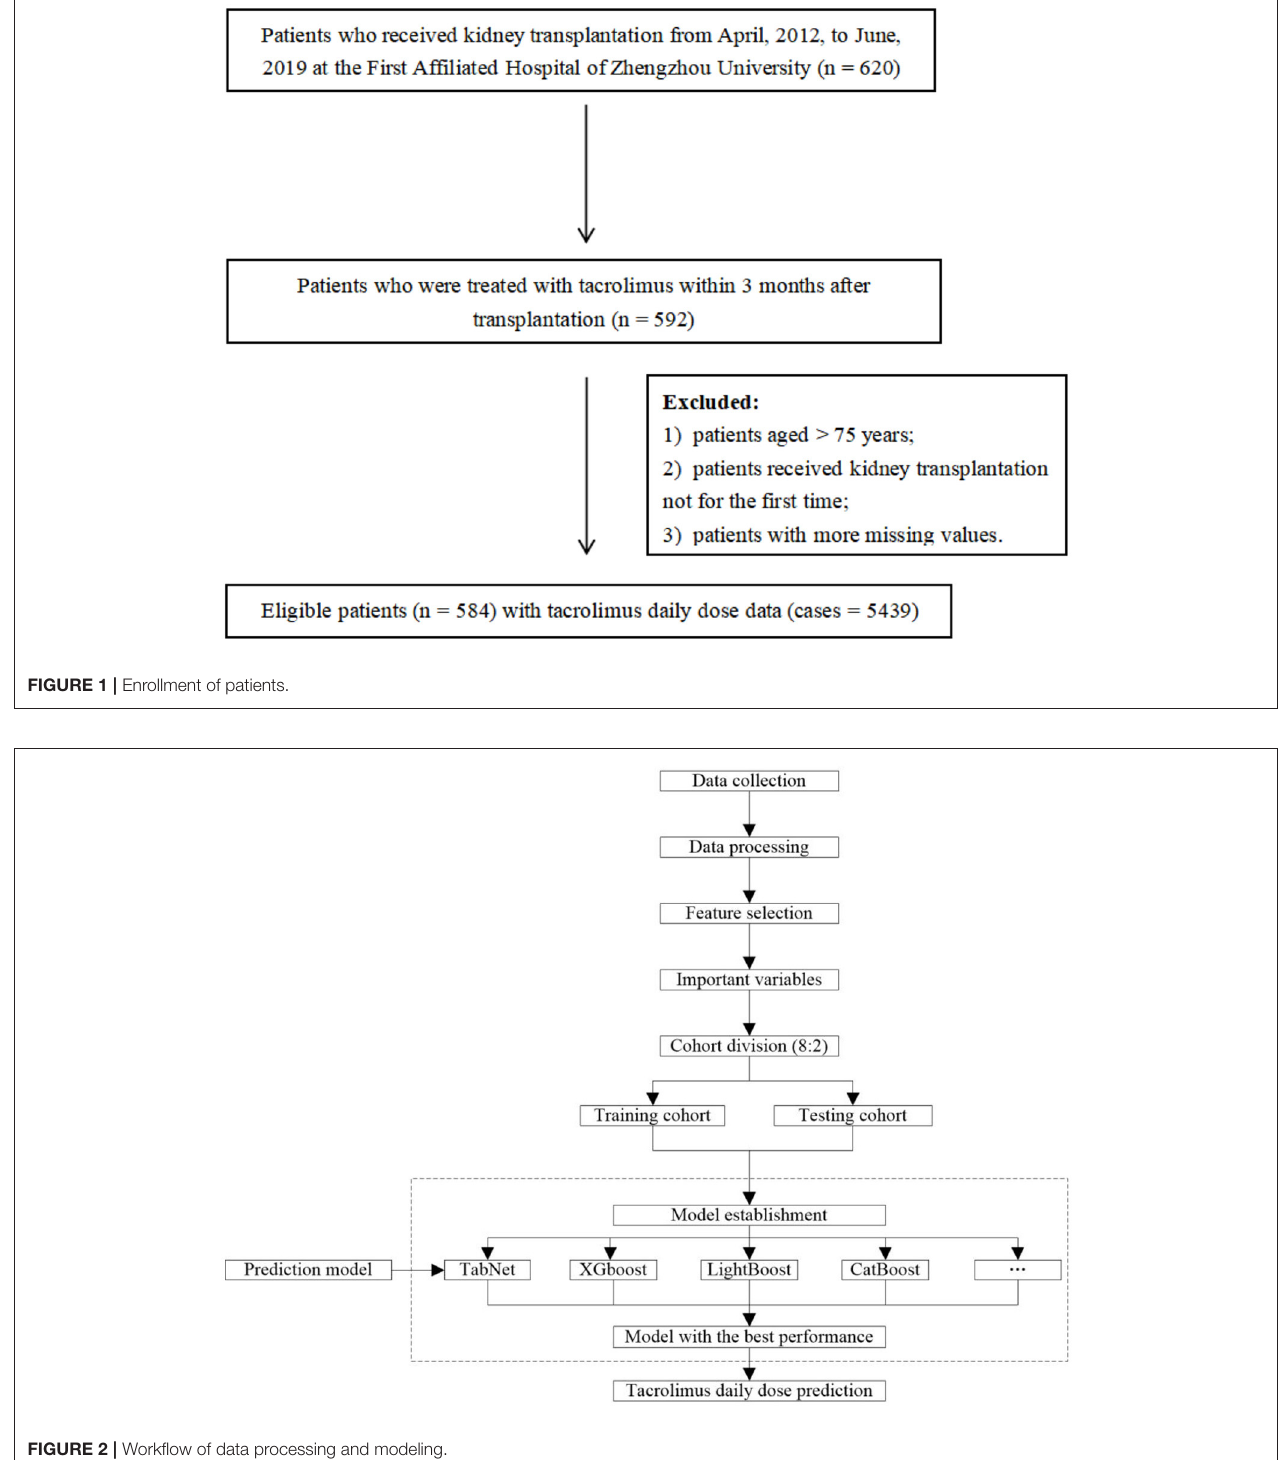
FIGURE 2 | Workflow of data processing and